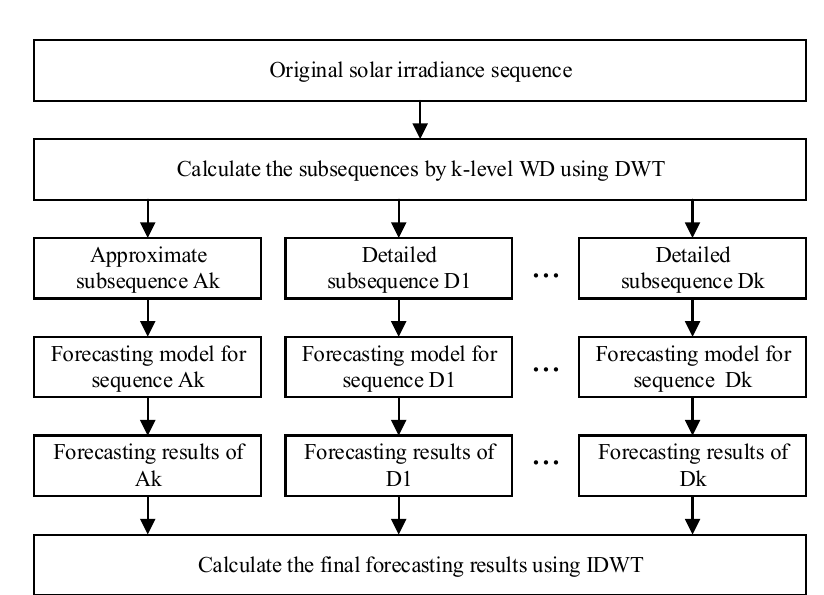
Figure 2. Wavelet decomposition tree.